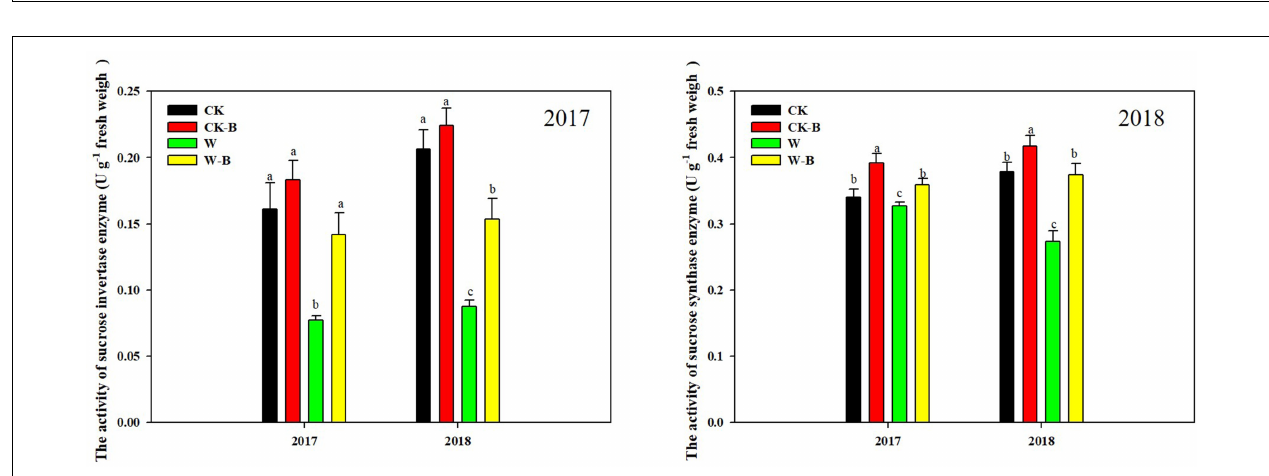
FIGURE 4 | The contents of hormones in different organs at the T2 stage. CK, control, no waterlogging stress; CK-B, spraying 6-BA on non-waterlogged plants; W, waterlogging; W-B, spraying 6-BA after waterlogging. Different letters on bars indicate the significant differences among treatments at P < 0.05 using the LSD test.